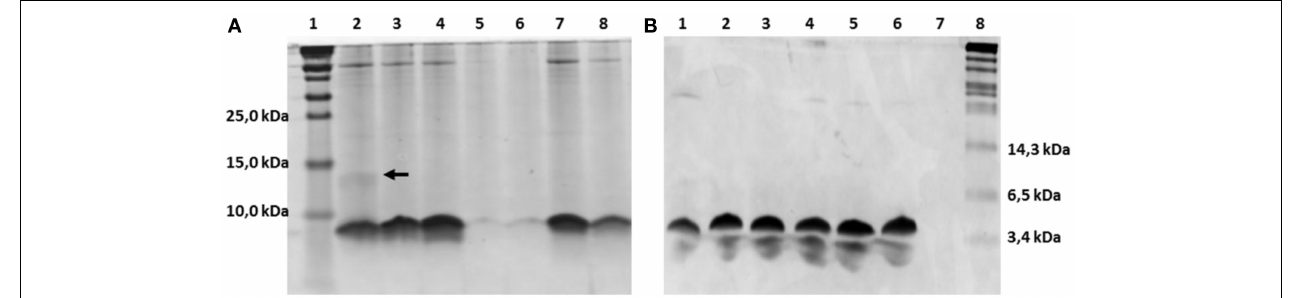
+ 1(leucine); Lane 7, + 2; Lane 8, + 3. The dimer of the − 2 variant is indicated by an arrow. (B) Purified hinge region analogs (3 μ g peptides were loaded per well). From left to right are − 2 (lane 1), − 1 (lane 2), wild type (lane 3), + 1 (leucine) (lane 4), + 2 (lane 5), + 3 (lane 6) and the protein marker (Biolabs) (lane 8). The molecular weight of the marker are indicated, from low to high 3.4kDa, 6.5kDa, and 14.3kDa.